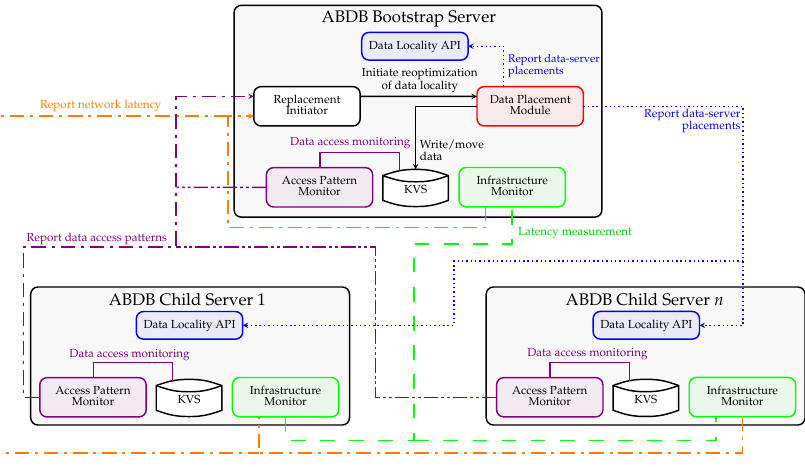
Figure 2. Architecture of